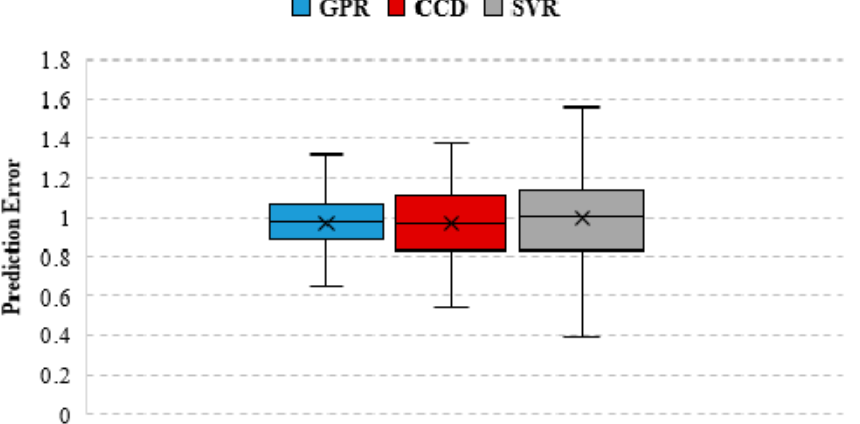
Figure 7. Predicted value versus the experimental value of concrete breakout capacities for the developed models and Concrete Capacity Design (CCD) method.